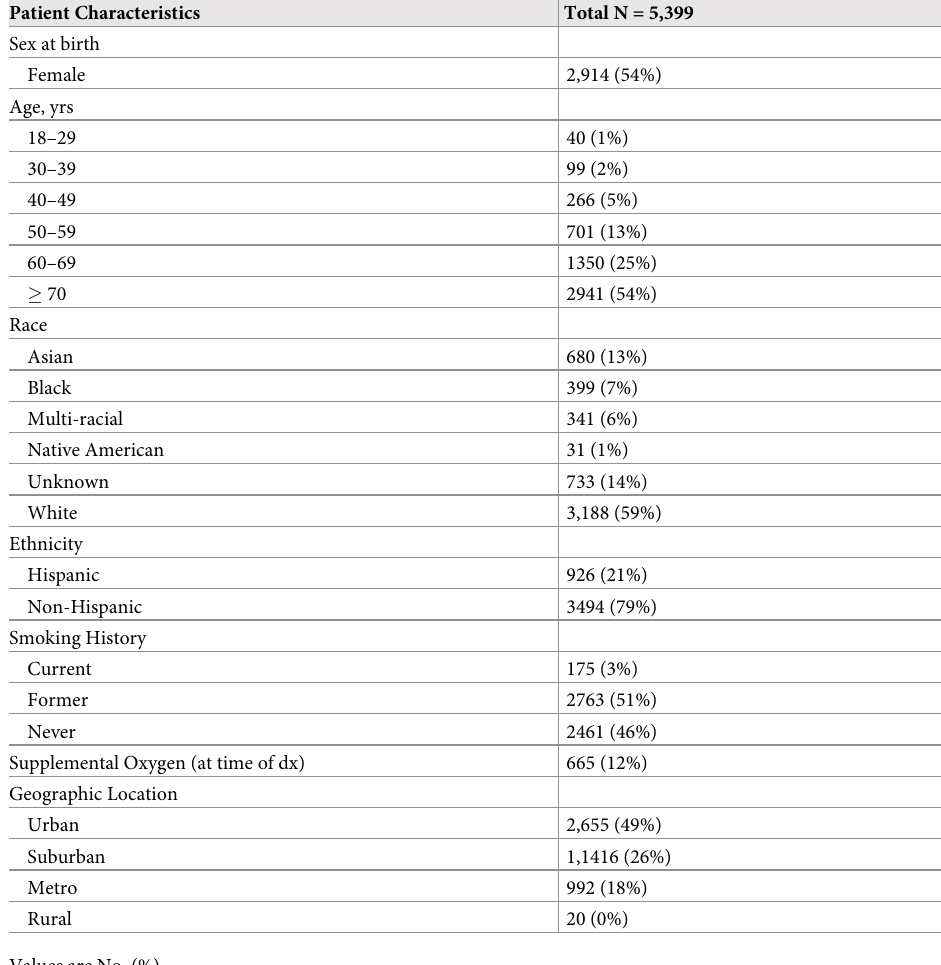
Table 1. Characteristics of patients identified by the